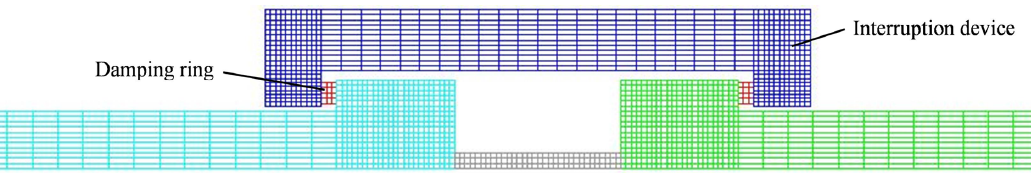
Figure 5. Structured mesh in the modified SHTB Model-3.